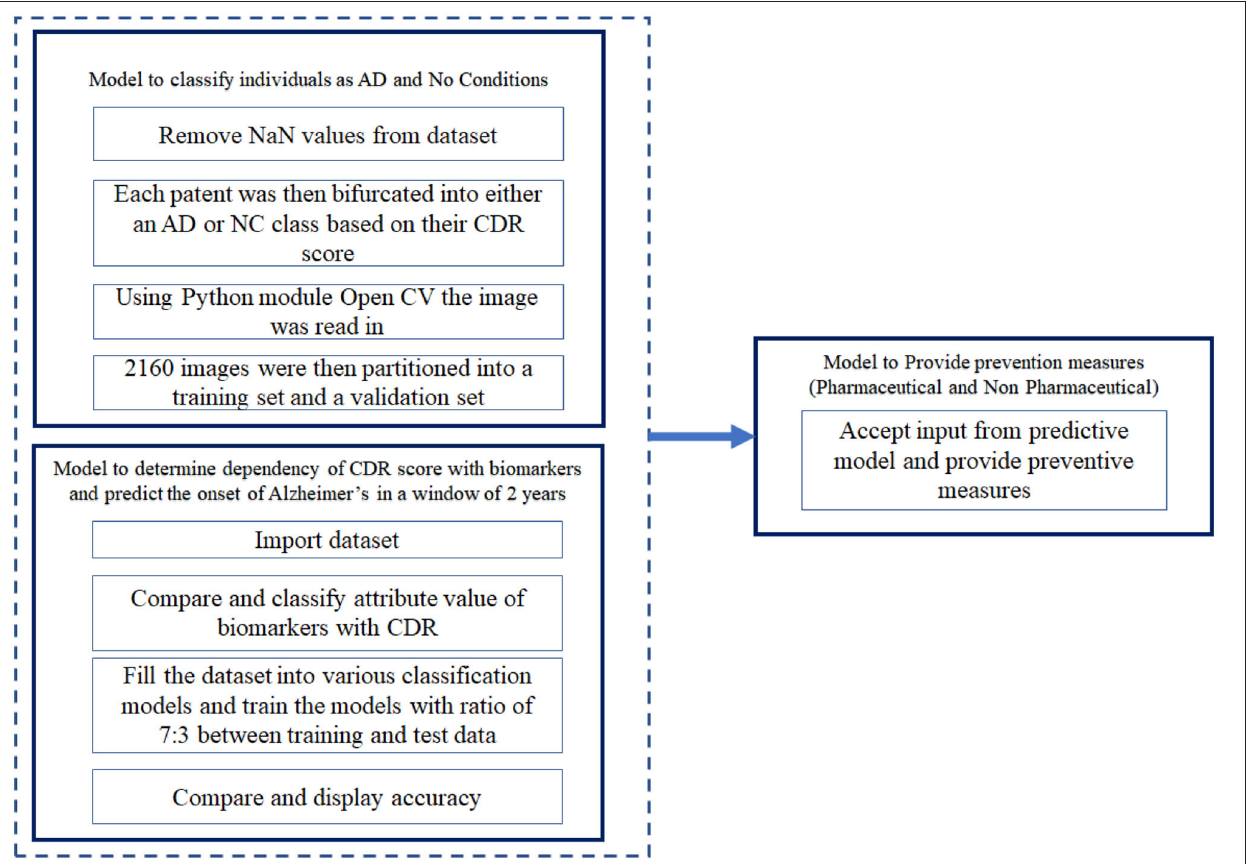
FIGURE 1 | Architecture of the